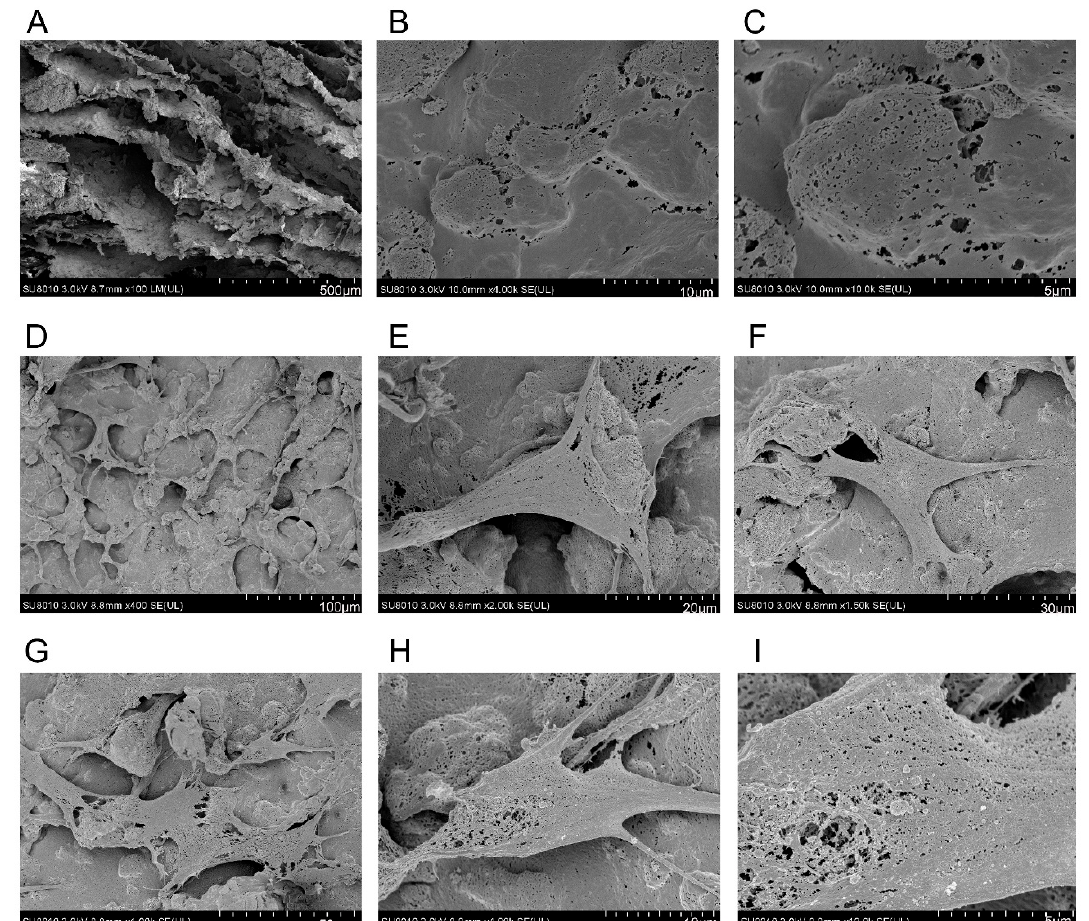
Figure 3. ( A ) Scanning electron microscope showing that the nHAC/PLA blocks were similar to the natural bone in terms of microstructure of natural bone in both main component and hierarchical microstructure. ( B , C ) the hAMSCs adhered to, extended, and produced a few extracellular matrix (ECM) on the nHAC/PLA surface after five days of cultivation. ( D – H ) The hAMSCs were in triangle, cube shape, or spindle shape with developed cytoplasmic extensions attached to the scaffold. ( I ) hAMSCs dramatically proliferated in the pore of the scaffold material and linked flakiness on the surface after 28 days cultivation. The cells became confluent, forming a distinct multilayer, and some cells were covered with deposits.